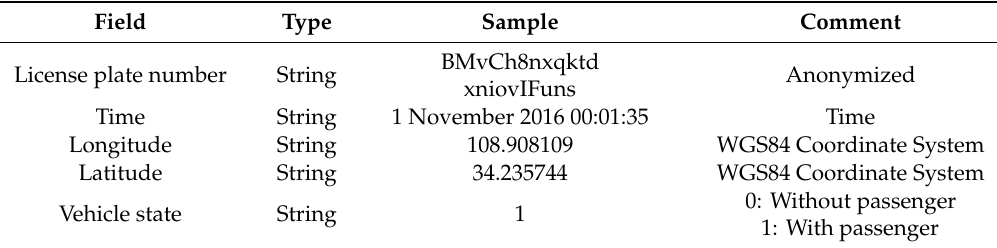
Table 1. An instance of taxi GPS